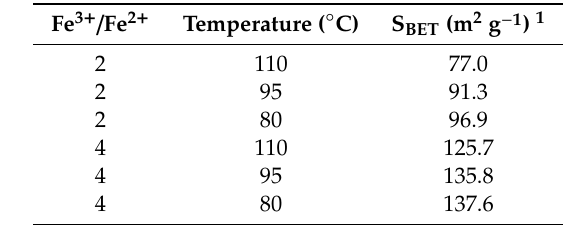
Table 1. Specific surface areas of magnetite solids precipitated at different reflux temperature and nominal Fe 3+ /Fe 2+ molar ratio.